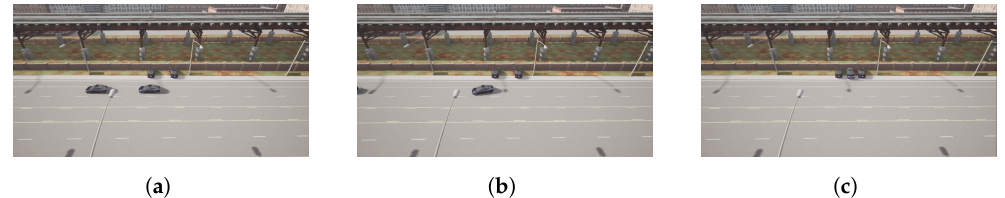
Figure 19. Position and reference in the line parking maneuver.